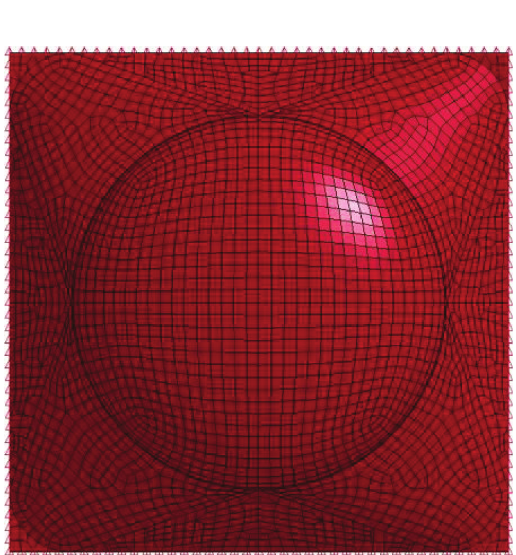
Figure 6: Finite element model with boundary conditions (mesh size: 100mm).